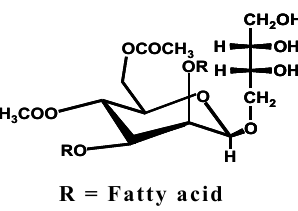
Figure 2. A structure of biosurfactant MEL-A which consists of 4- O -[ β - D -mannopyranosyl] meso -erythritol], esterified two fatty acids and two acetic